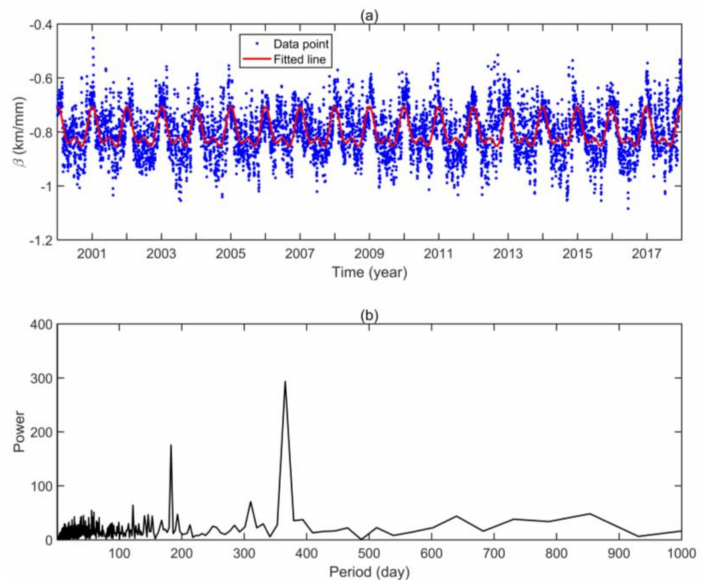
Figure 3. ( a ) Seasonal variations in the β from 2001 to 2018 using the daily ERA5-derived PWV and geopotential height data over Antarctica, and ( b ) the results of periodicity detection for the β using the FFT